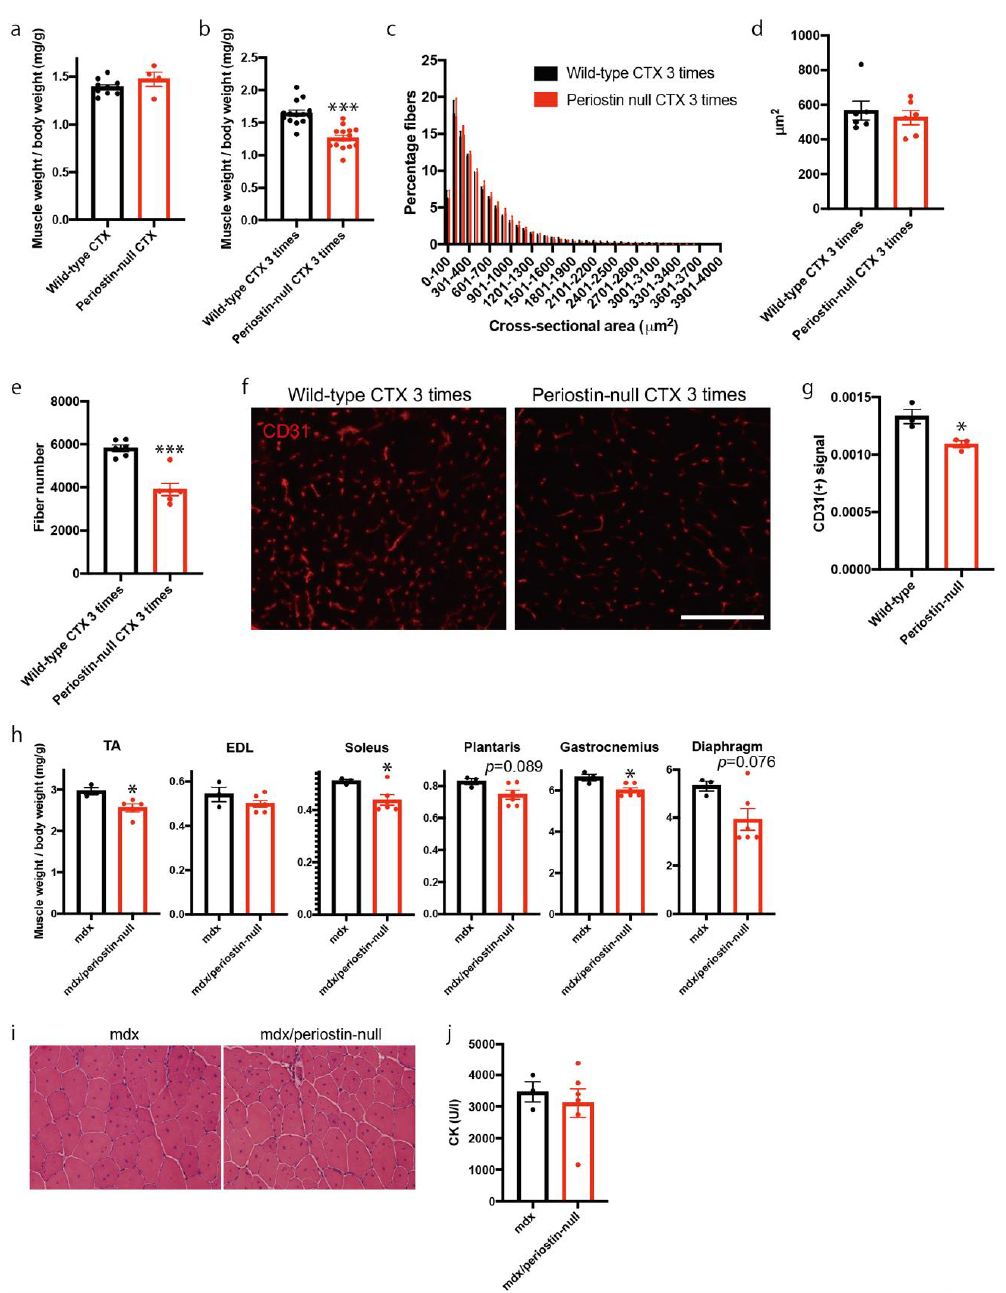
Figure 4. Loss of periostin causes a decrease in muscle fiber number during repeated muscle regeneration. ( a ) Muscle weight 7 days after the induction of muscle regeneration. n = 4–10. ( b ) Muscle weight 7 days after repeated induction of muscle regeneration. n = 14. ( c ) CSA of regenerating muscle fiber after repeated muscle regeneration. n = 6. ( d ) The average of CSA. n = 6. ( e ) The number of muscle fibers after repeated muscle regeneration. n = 6. ( f ) Immunostaining of CD31 after repeated muscle regeneration. Bar: 75 µ m. ( g ) The number of CD31-positive blood vessels. n = 3. ( h ) Muscle weight of 12-week-old mdx and mdx/periostin-null mice. n = 3–6. ( i ) Representative H&E staining of mdx and mdx/periostin-null mice. ( j ) Plasma CK levels in mdx and mdx/periostin-null mice. n = 3–6. * p < 0.05 and *** p < 0.001 by Student’s t -test. Error bars indicate